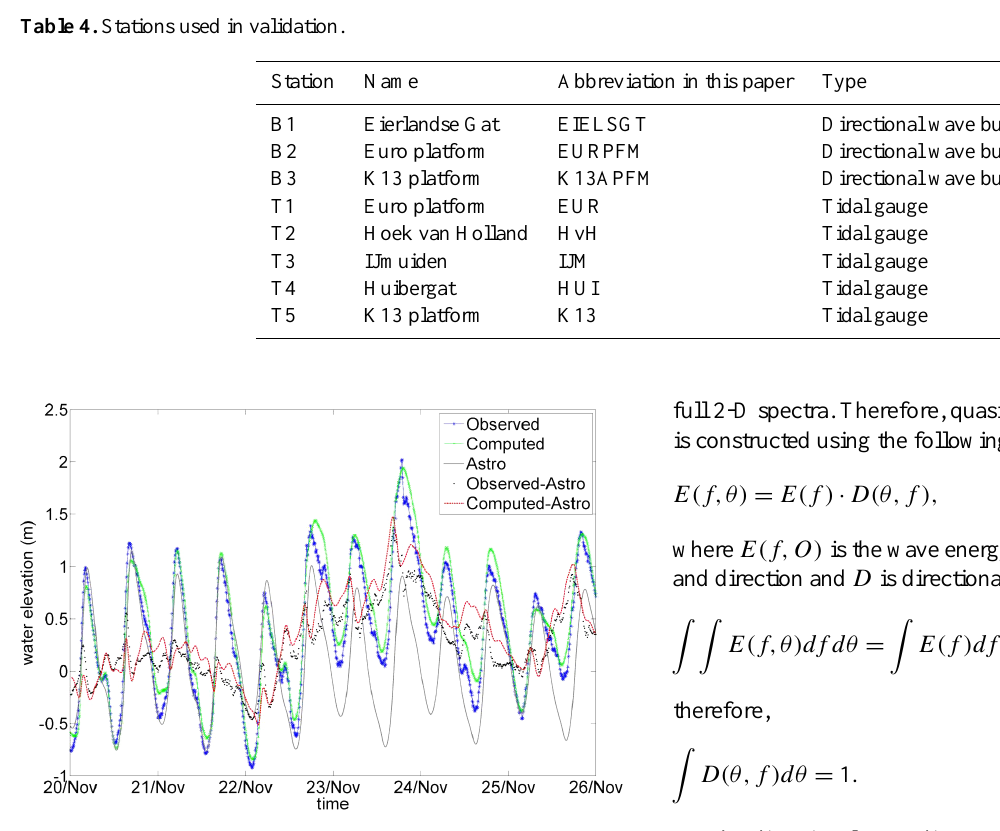
Figure 3. Water elevation for IJmuiden (IJM) during the storm in November 2009: blue – observed water level; green – computed water level; black – observed surge; red – computed surge; grey – astronomical prediction.